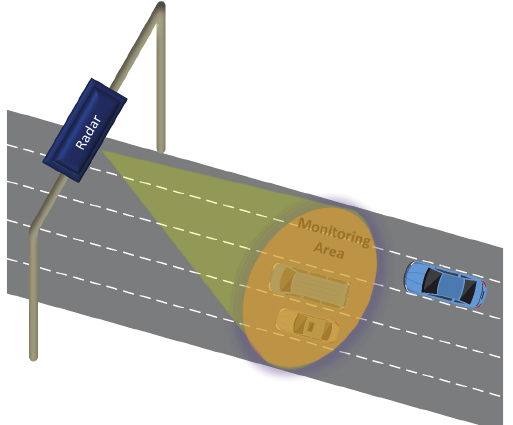
Figure 1. Schematic diagram of top-mounted multi-target radar.